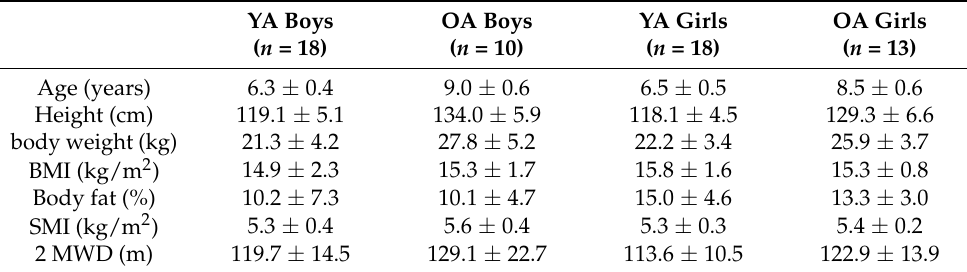
Table 1. Demographic characteristics of